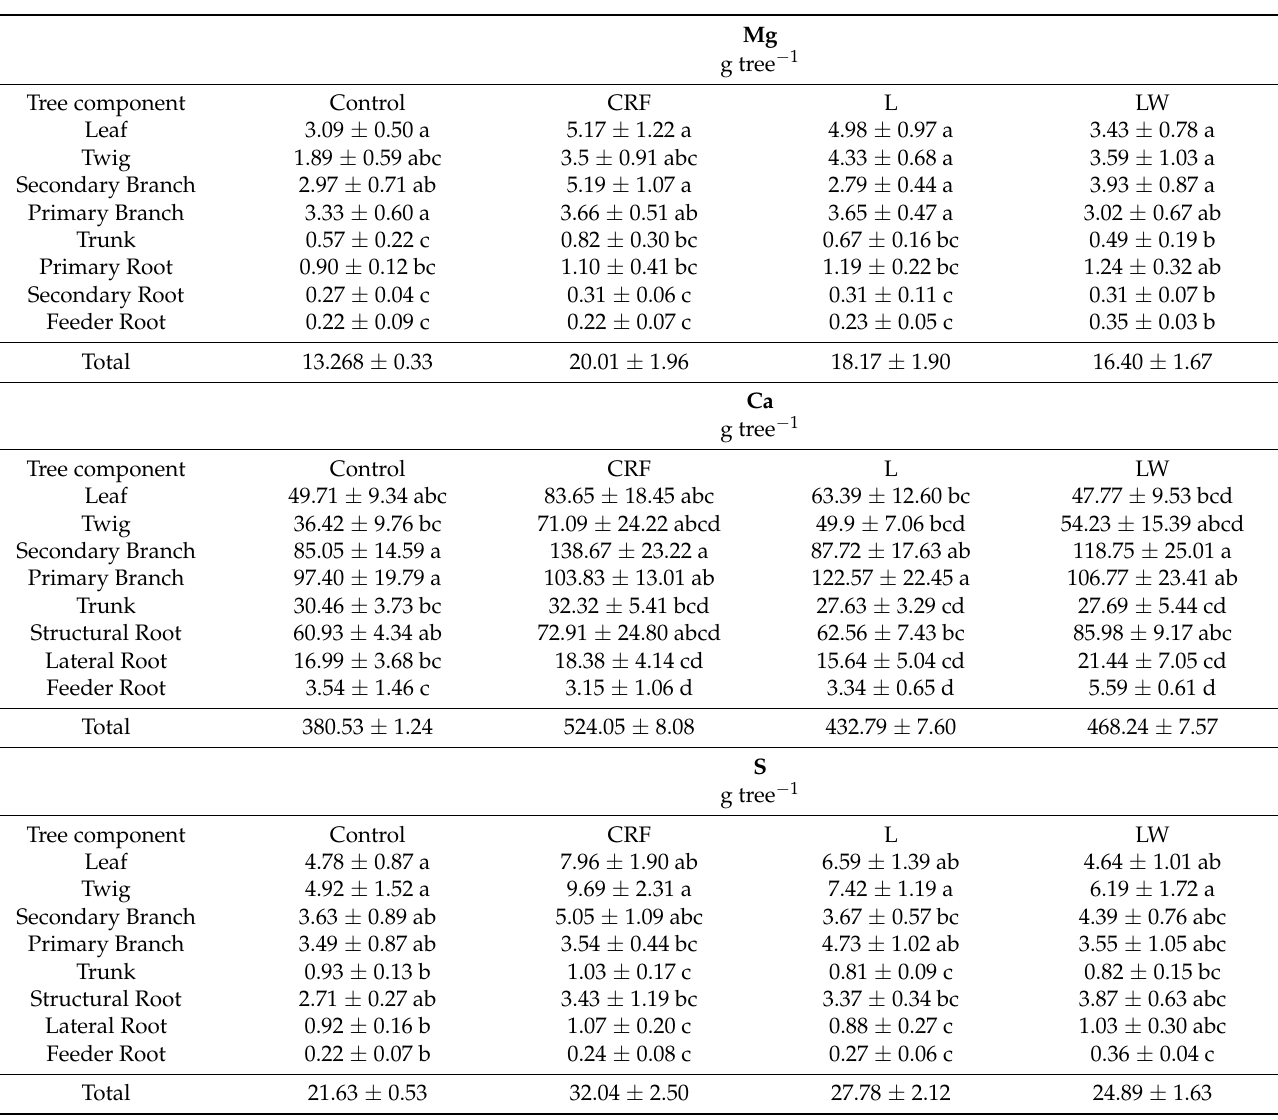
Table 2. Magnesium (Mg), calcium (Ca), and potassium (S) contents per individual components and tree total. Six-year-old Huanglongbing-affected ‘Ruby Red’ grapefruit trees grafted on sour orange rootstock were used. Treatments consisted of two liquid (L and LW) and two granular fertilizers (Control and controlled-release fertilizer (CRF)). A Kruskal–Wallis test was used in combination with a Tukey’s honestly significant difference (HSD) test to identify and test significant differences in total nutrients in individual tree components (differences signified by letters). Data represents means ( n = 4) ± standard error.